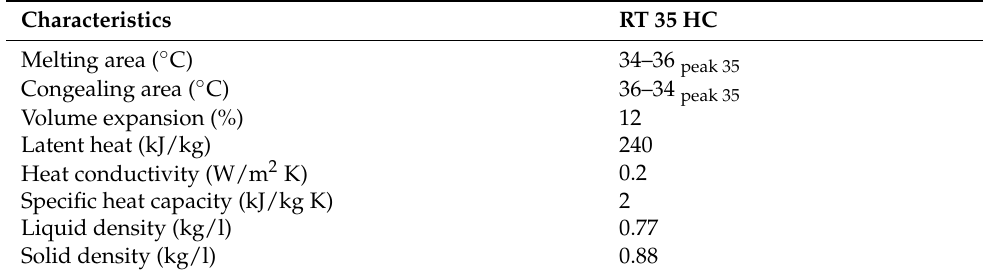
Table 1. Characteristics of PCMs